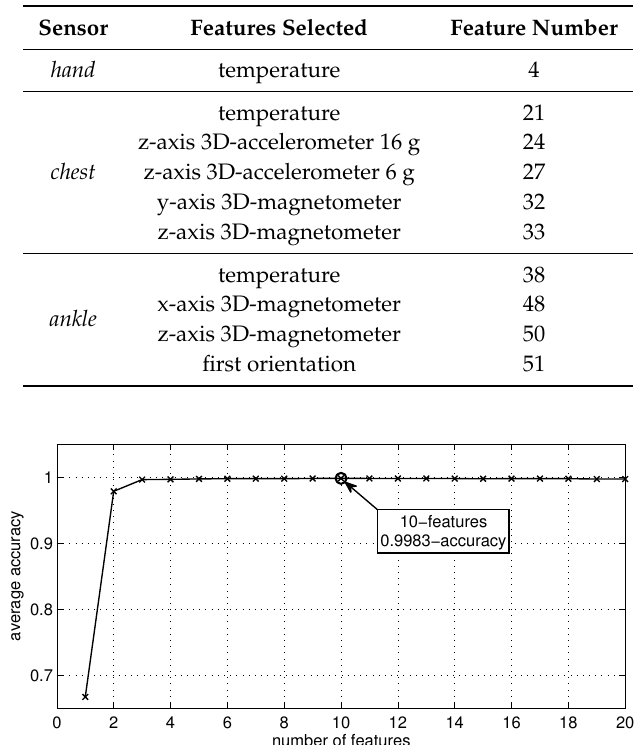
Table 4. Retained features using the recursive feature elimination (RFE) technique.